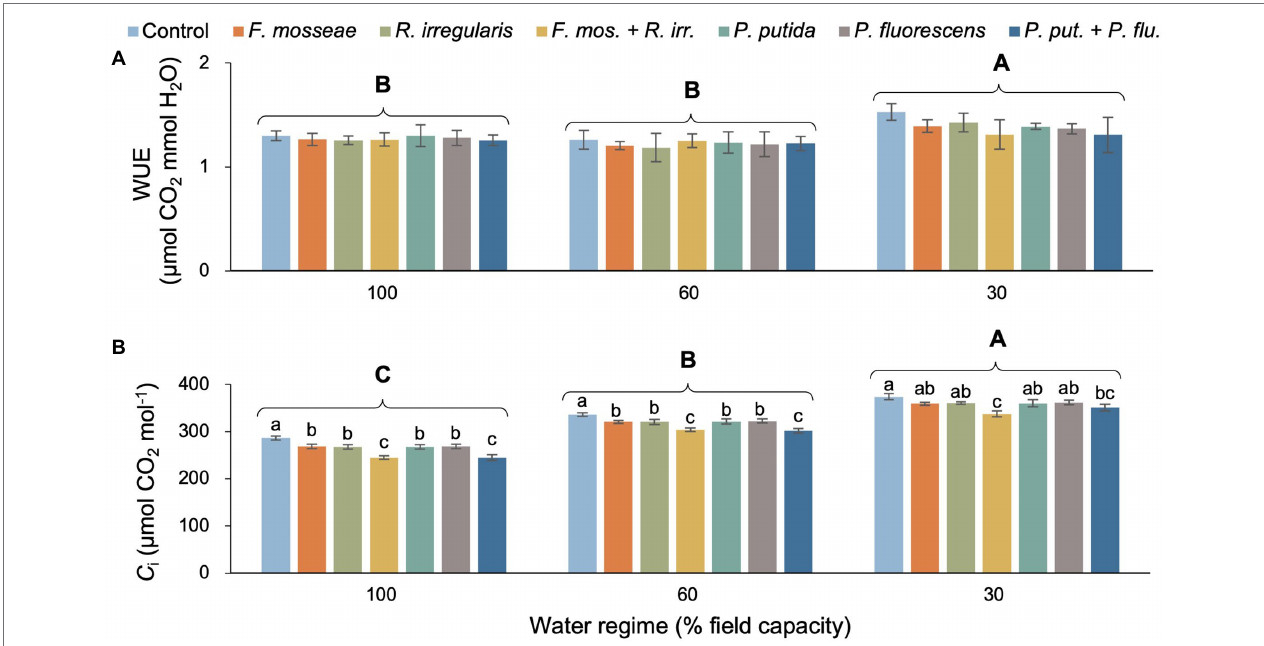
FIGURE 2 | Effect of water regime and soil microbial inoculation on the water use efficiency (WUE; A ) and intracellular CO 2 concentration ( C i ; B ) of M. communis seedlings. For both variables, only the main effects of water regime and inoculation treatment were significant ( Table 2 ). Different upper-case letters indicate significant differences between water regimes. Different lower-case letters indicate significant differences between microbial inoculation treatments within each water regime (Duncan’s new multiple range test, α = 0.05).